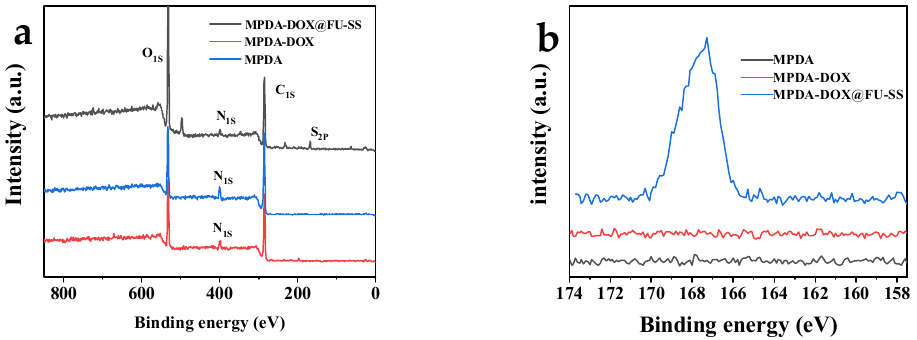
Figure 6. X-ray photoelectron spectroscopy spectrum. ( a ) Full spectrum. ( b ) X-ray photoelectron spectroscopy comparison diagram of S.